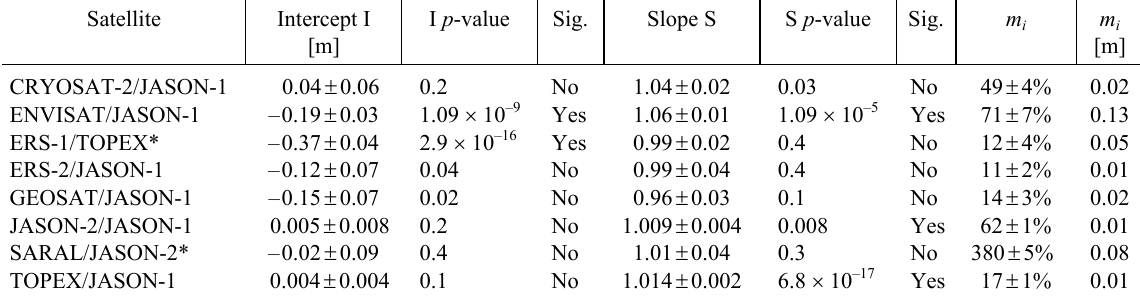
Table 4. Properties of fitted regression lines for intercomparison of data from various satellites. Sig. stands for statistical significance at a 99% level and m i is a modulation index that represents time variability of the bias